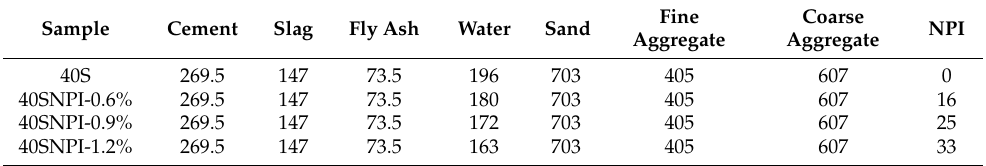
Table 2. Mix design of concrete (kg/m 3 ).